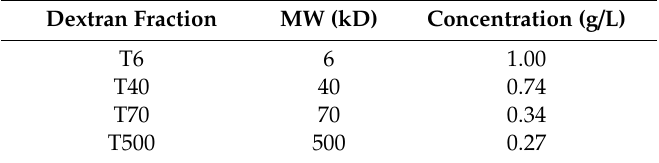
Table 1. Dextran molecular weights, suppliers, and concentration used in the sample